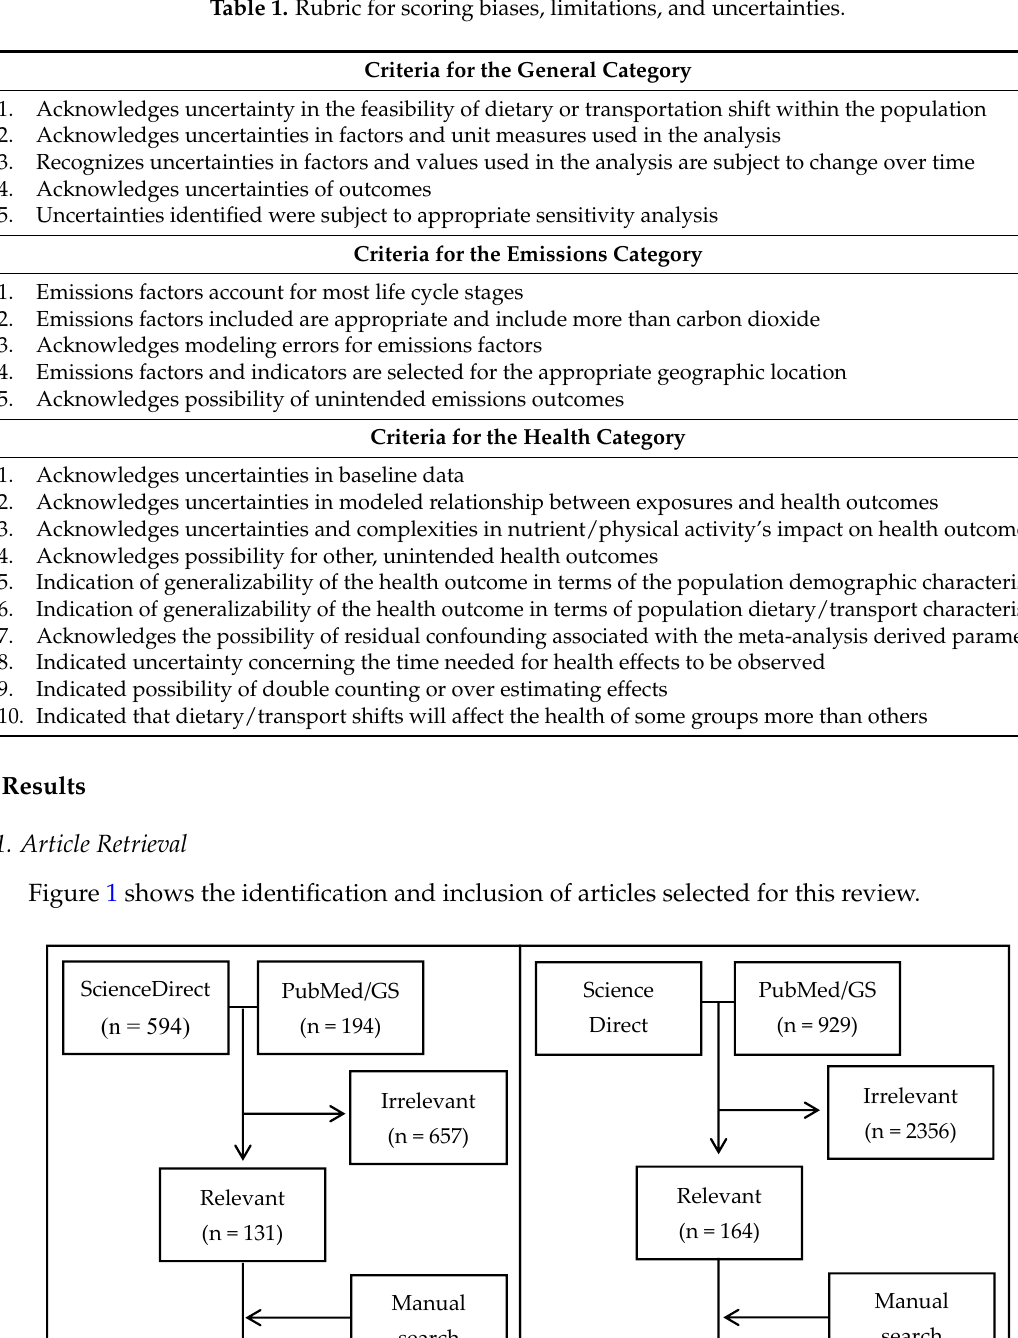
Table 1. Rubric for scoring biases, limitations, and uncertainties.